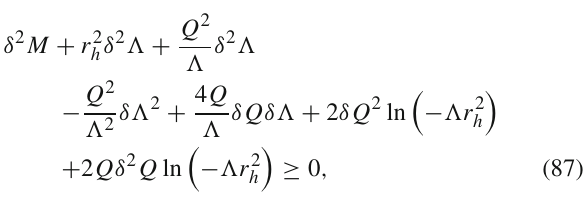
Fig. 1 Plot of the blackening factor f ( r ) for different values of mass M when Q = 1 and (cid:3) = −